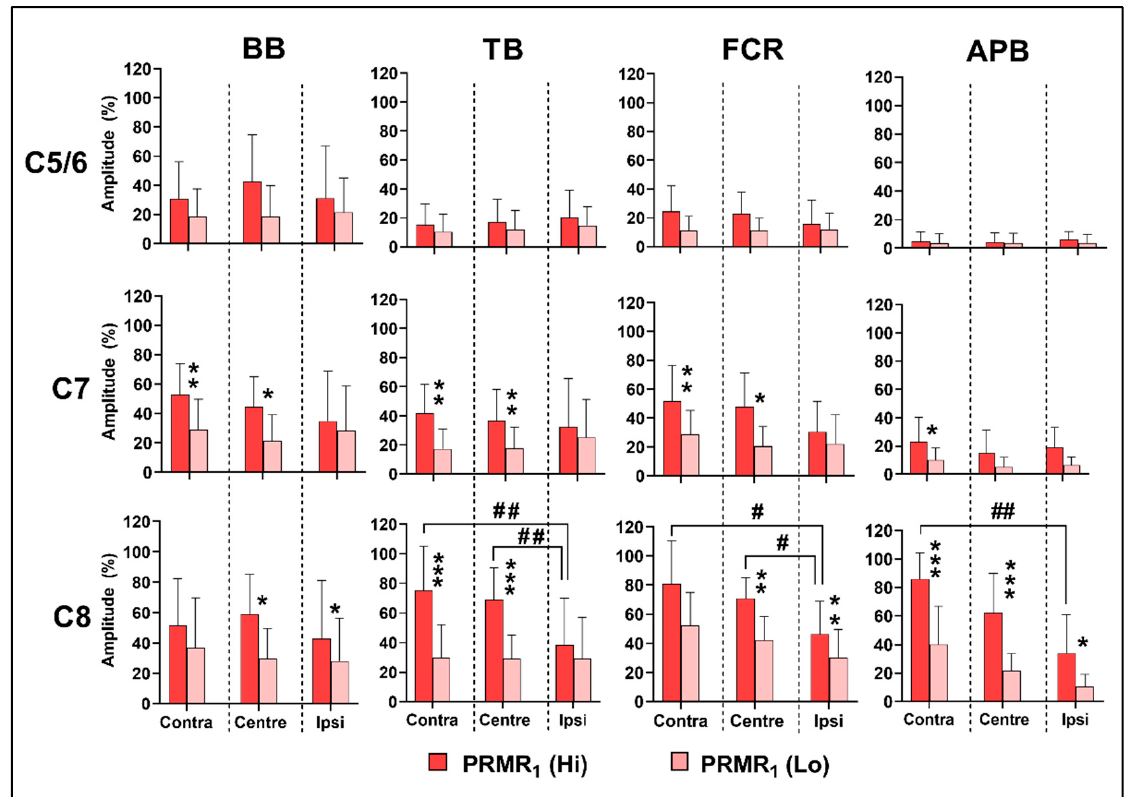
Figure 3. Group mean ± SD amplitude of PRMR 1 across spinal levels (C5/6, C7 and C8), lateral locations (contralateral, central and ipsilateral) and intensities (Hi = dark; Lo = light) in BB, TB, FCR and APB. Asterisks infer significantly greater PRMR 1 response comparing high with low stimulus intensity (* p < 0.05; ** p < 0.01; *** p < 0.001). Hash symbols infer significantly lower PRMR 1 response at ipsilateral stimulus location (# p < 0.05; ## p < 0.01).